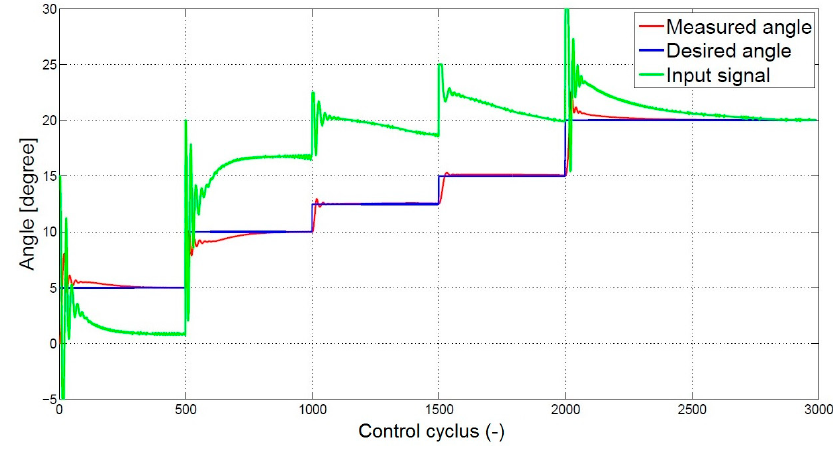
Figure 8. Response of the system following a reference trajectory.